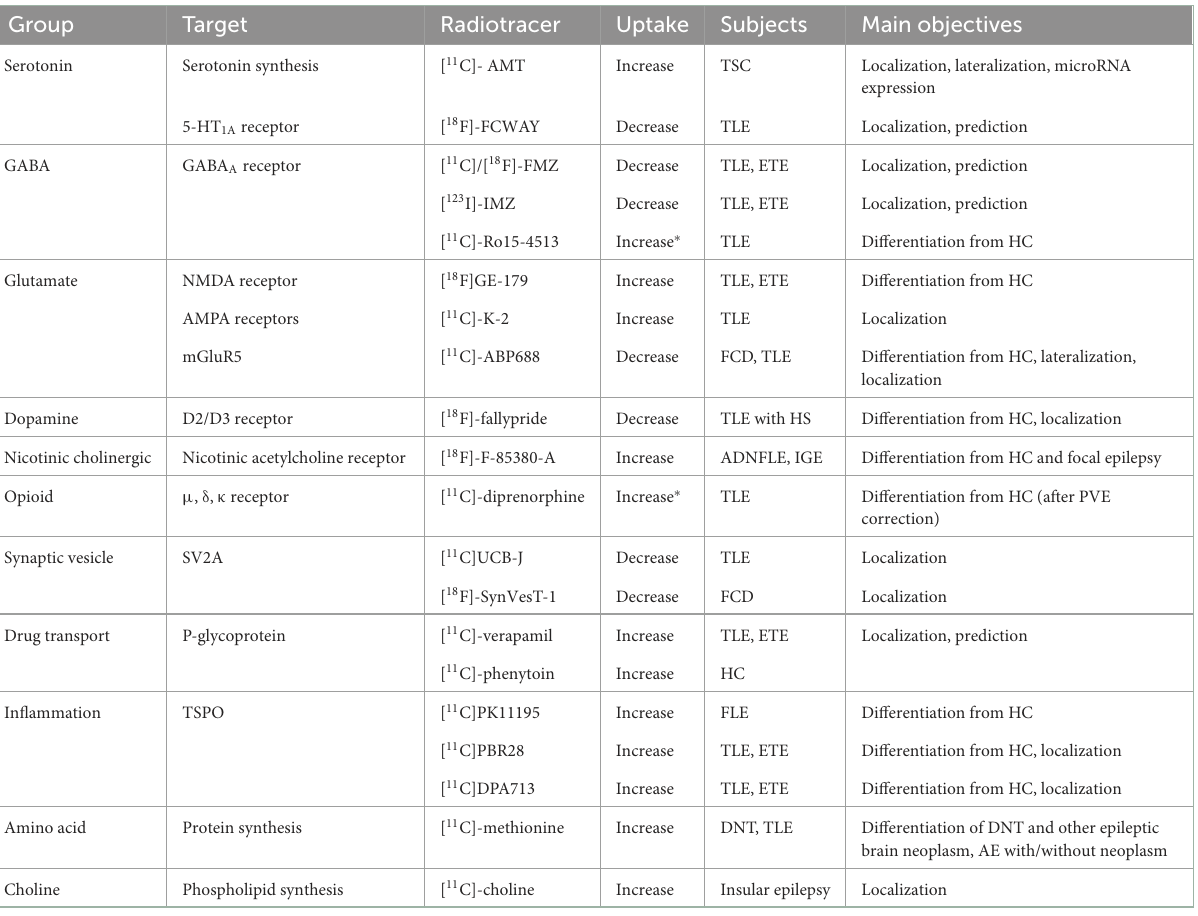
TABLE 1 Overview of non-FDG radiotracers recently used in